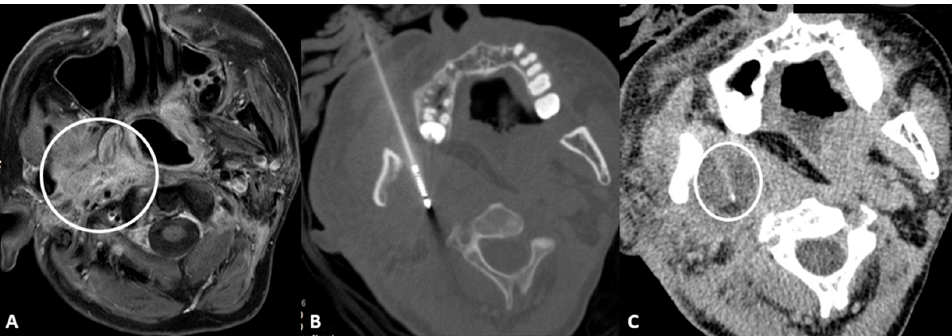
Figure 1. 56-year-old male with neuropathic pain due to right oropharyngeal squamocellular carci- noma recurrence after tracheostomy, neck lymph node dissection, mandibulotomy, right oropha- ryngeal resection with free anterolateral thigh flap. ( A ) T1-weighted postcontrast axial MRI scan showing malignant involvement of trigeminal nerve (circle). ( B ) Axial CT scan showing cryoabla- tion needle placement. ( C ) Intraprocedural axial CT scan showing ice ball formation around the needle (circle).